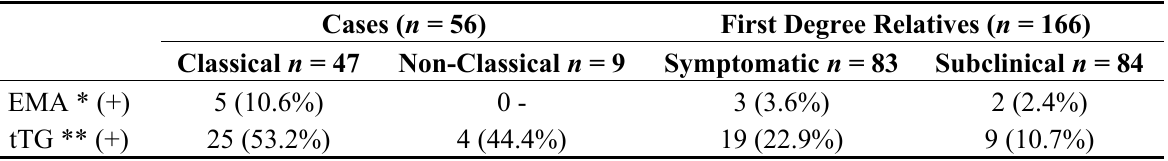
Table 3. Antiendomysial antibodies and antitransglutaminases in celiac cases and first-degree relatives.